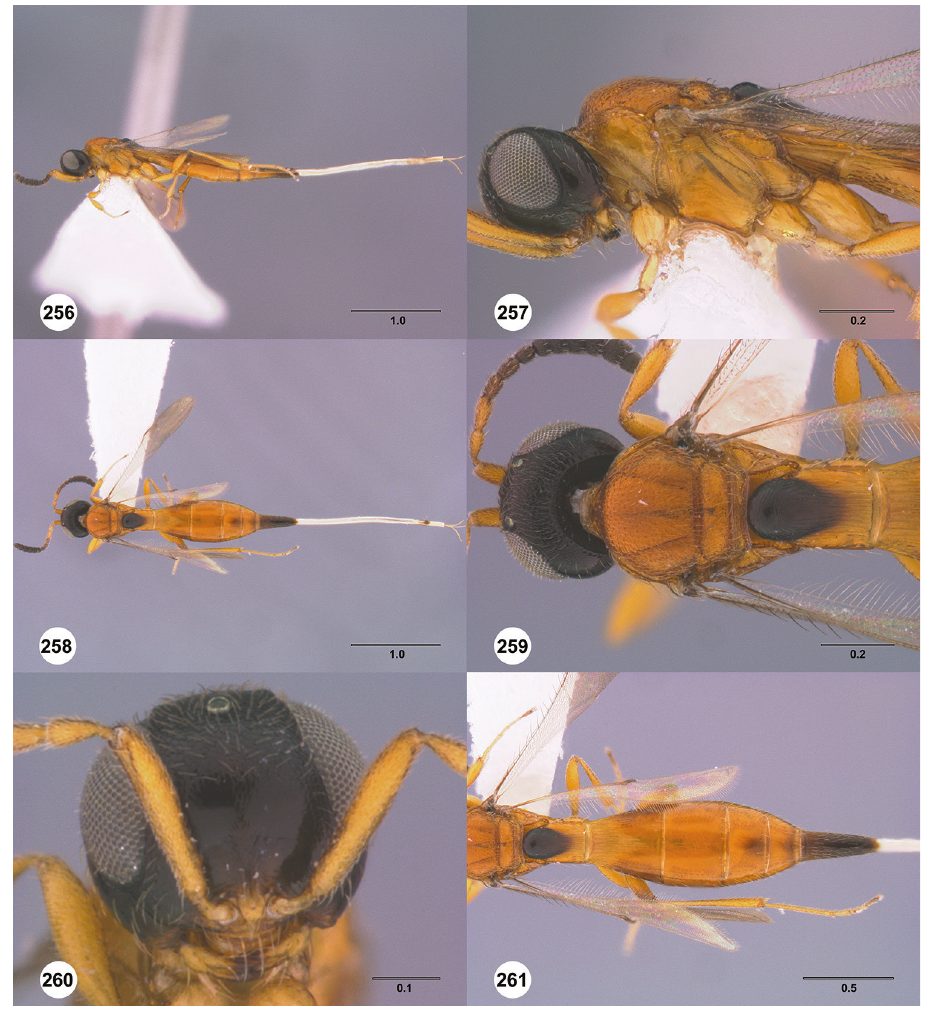
Figures 256–261. Calliscelio telum sp. n., female, holotype (OSUC 276704). 256 Lateral habi- tus 257 Head and mesosoma, lateral view 258 Dorsal habitus 259 Head and mesosoma, dorsal view 260 Head, anterior view 261 Metasoma, dorsal view. Scale bars in millimeters. Color of metasoma in female: orange throughout; variably orange to pale brown. Color of metasoma in male: T5–T7 brown to black, otherwise orange. Horn on T1 in female: large and distinct. Sculpture of T1 horn dorsally: rugulose. Sculpture of posterior margin of T1 in female: longitudinally striate throughout. Sculpture of T1 in male: longitudinally striate. Development of longitudinal striae on T2 in female: reaching posterior margin of T2. Sculpture of T3: smooth; smooth with longitudinal submedian striae. Shape of T6 in female: distinctly elongate, at least 2.0× longer than wide. Sculpture of S3: